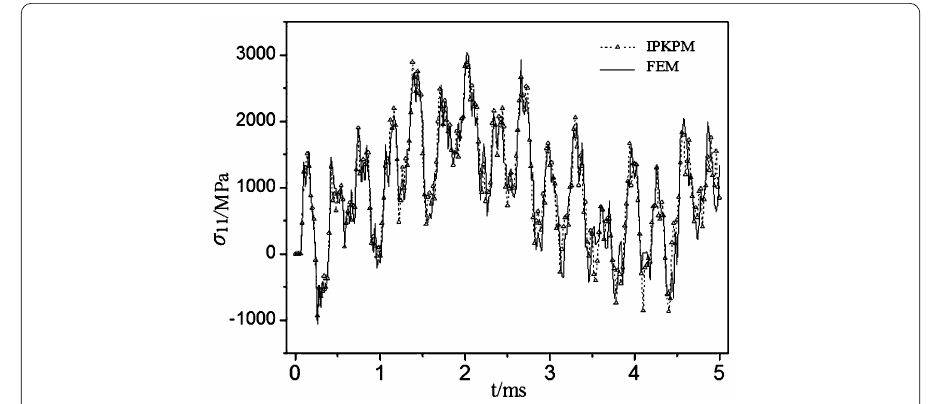
Figure 9 The time-dependent stress σ 11 at the point